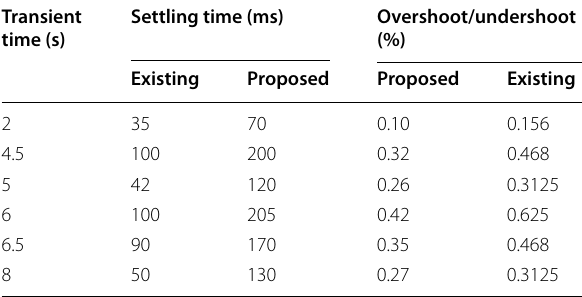
Table 8 Quantitative analysis for DC-bus voltage Transient Settling time time (s)